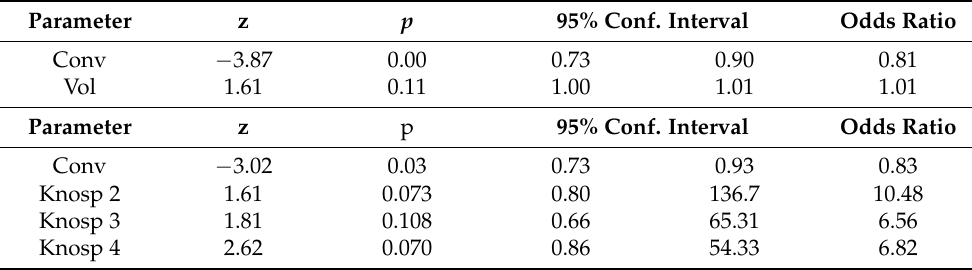
Table 5. The upper section of the table: univariate logistic regression for convexity (Conv) and volume (Vol). The lower section of the table: bivariate analysis showed that for tumors with a similar volume, the presence of irregularities in their shape (expressed by low Conv values) has a major role in the determination of the tumor resection extent. For Knosp grade, Odds Ratios referred to Knosp grade